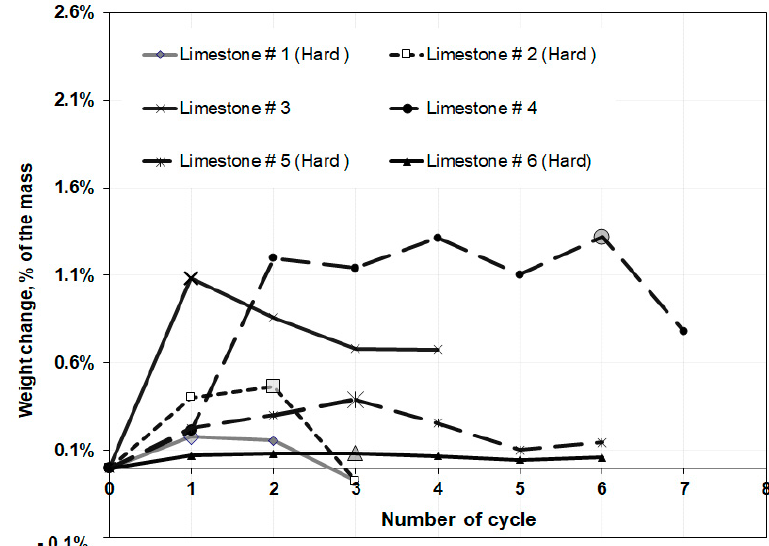
Figure 2. Kinetic of stones’ weight changes during the crystallization test.